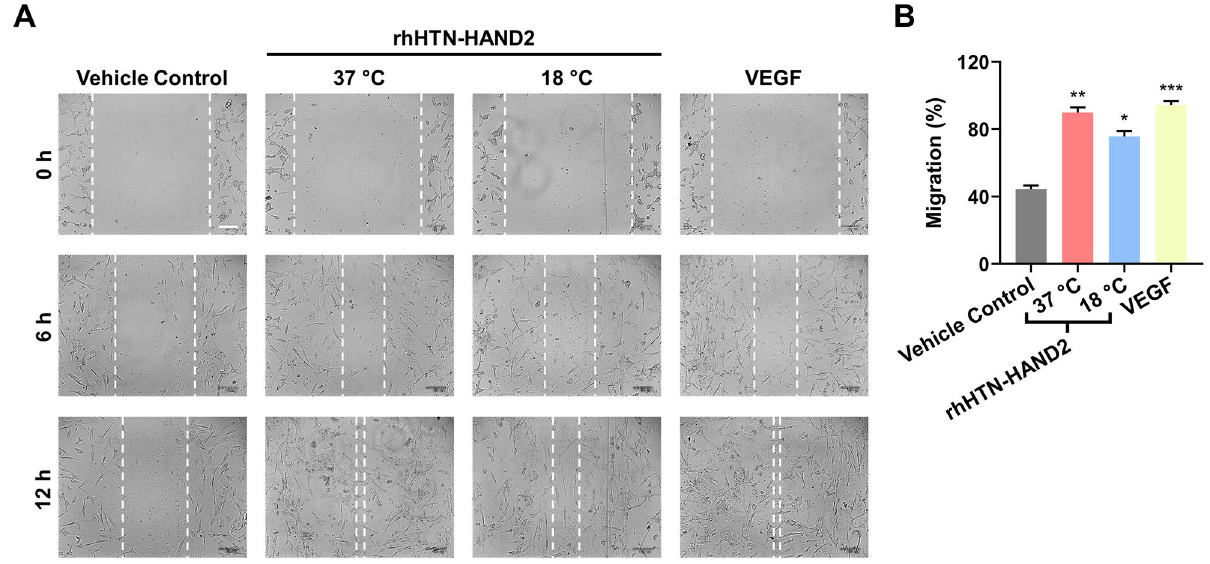
Figure 7. Effect of purified rhHAND2 fusion proteins on the migration of endothelial cells. ( A ) Microscopy analysis of the migration-inducing potential of rhHTN-HAND2 proteins transduced, non-transduced, and VEGF induced HUVECs. Scale bar: 100 μm. ( B ) Quantitative data of the migration in ( A ). The quantitative data shown are mean ± SEM (n = 3). * P < 0.01; ** P < 0.001, *** P < 0.0001.